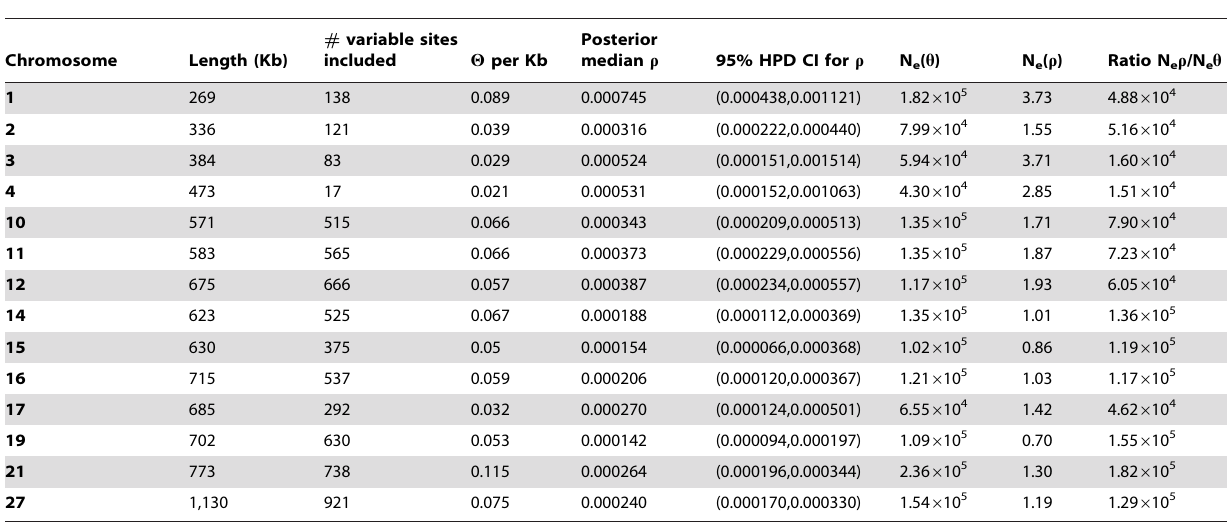
Table 1. Mutation and recombination diversity give two different estimates of effective population size of the C¸ukurova